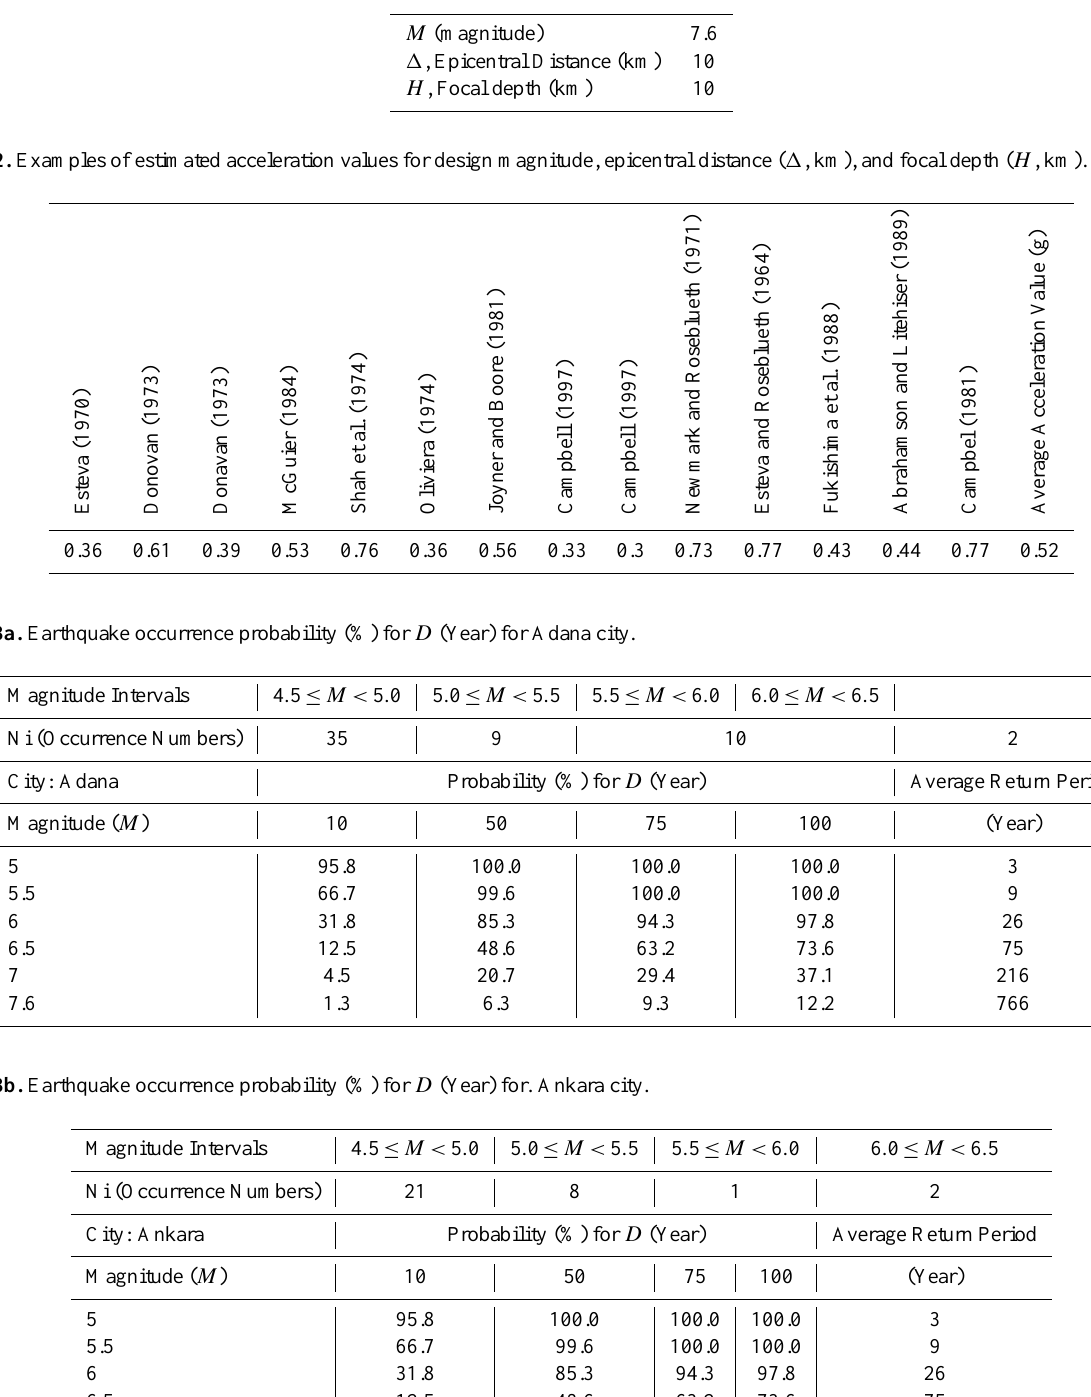
Table 1. Earthquake magnitude ranges for each city within a 100-km radius. Magnitude Ranges